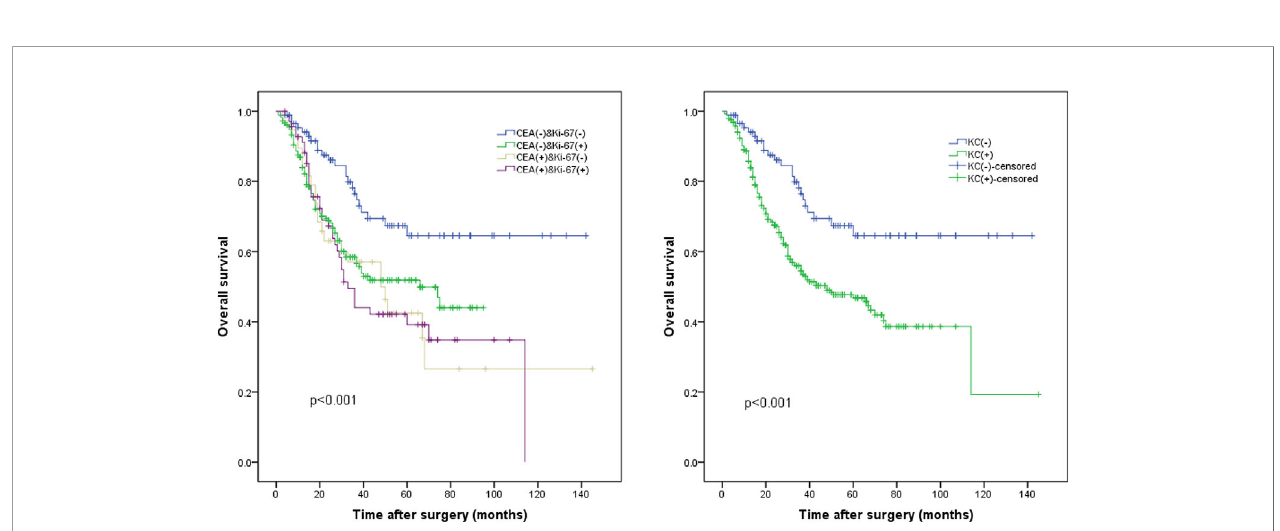
FIGURE 2 | The whole cohort was divided into four subgroups according to (A) the KC status. (B) The KC(-) group (low Ki-67 index and normal carcinoembryonic antigen [CEA] levels) and the KC(+) group (high Ki-67 index or/and high CEA levels), p <